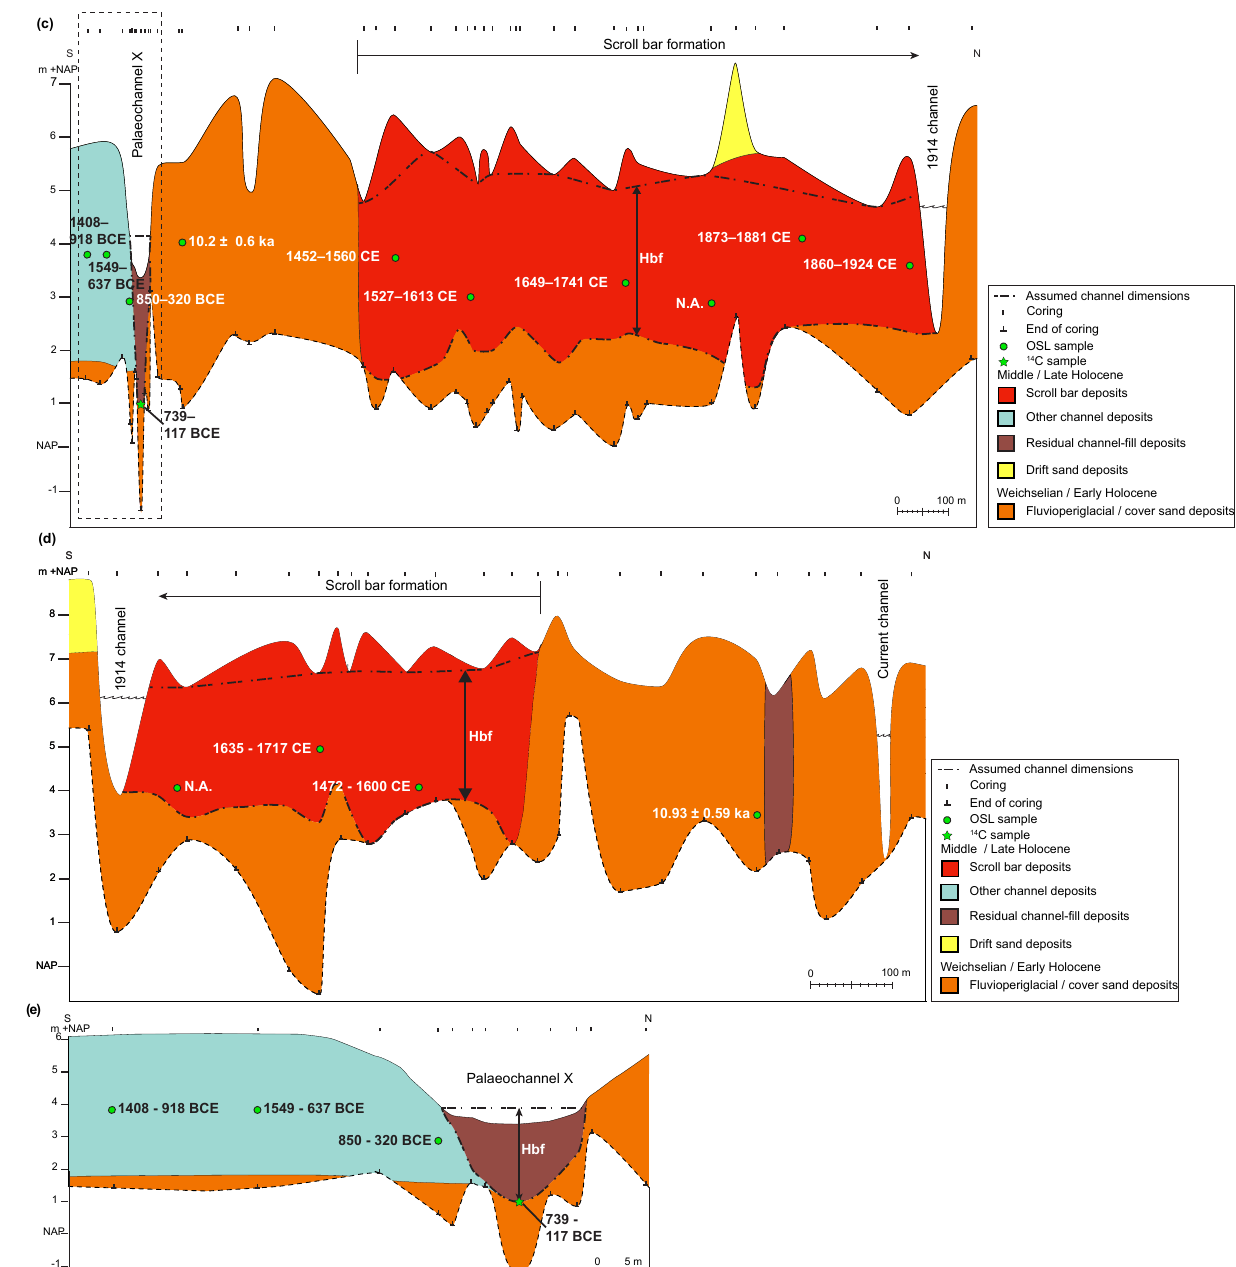
Figure 4. Stratigraphic cross sections of the study sites (for location see Fig. 1). Lithological cross sections of Junnerkoeland (a) and Prathoek (b) . Lithogenetic cross sections of Junnerkoeland (c) and Prathoek (d) including the OSL samples by Quik and Wallinga (2018) and OSL and 14 C dating results from this study. The surface and erosive base elevation are indicated with dashed lines, resulting in the inferred bankfull channel depth ( H bf ). (e) Zoomed-in lithogenic cross section of Palaeochannel X . The thick dashed line indicates the bankfull level of the